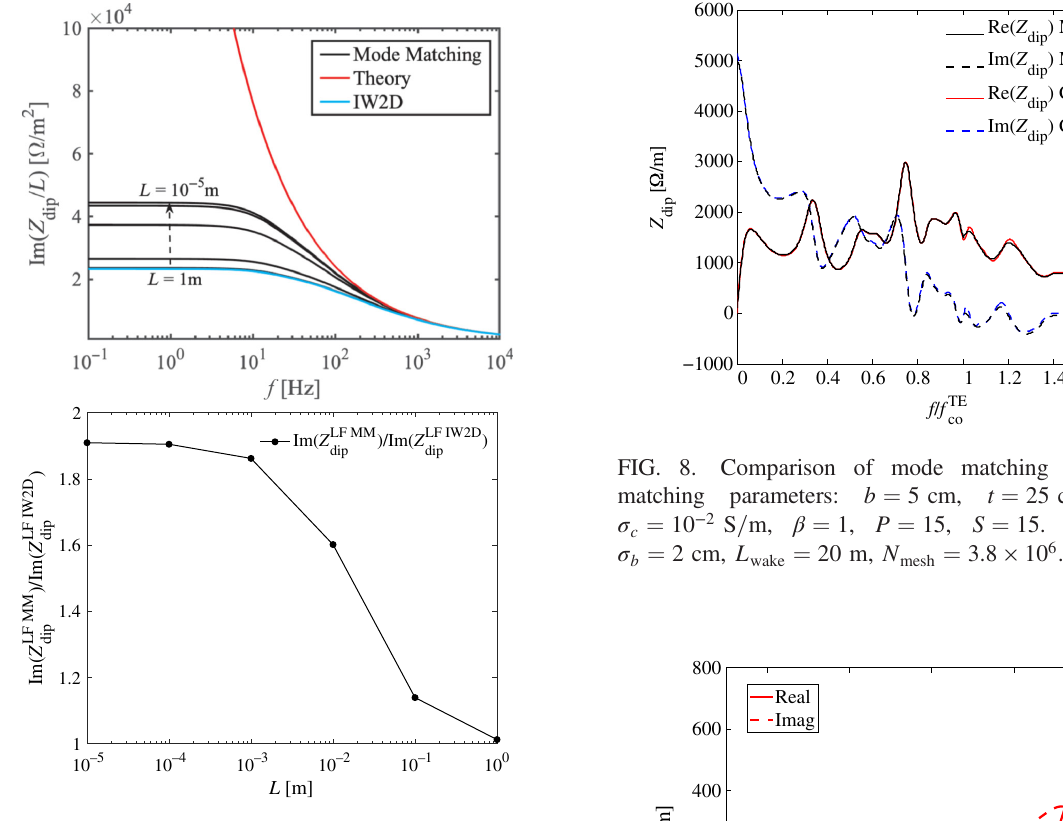
FIG. 7. Imaginary part of the dipolar impedance from the mode matching and IW 2 D model normalized by the cavity length (top) and ratio in the LF regime (bottom). Mode matching parameters: